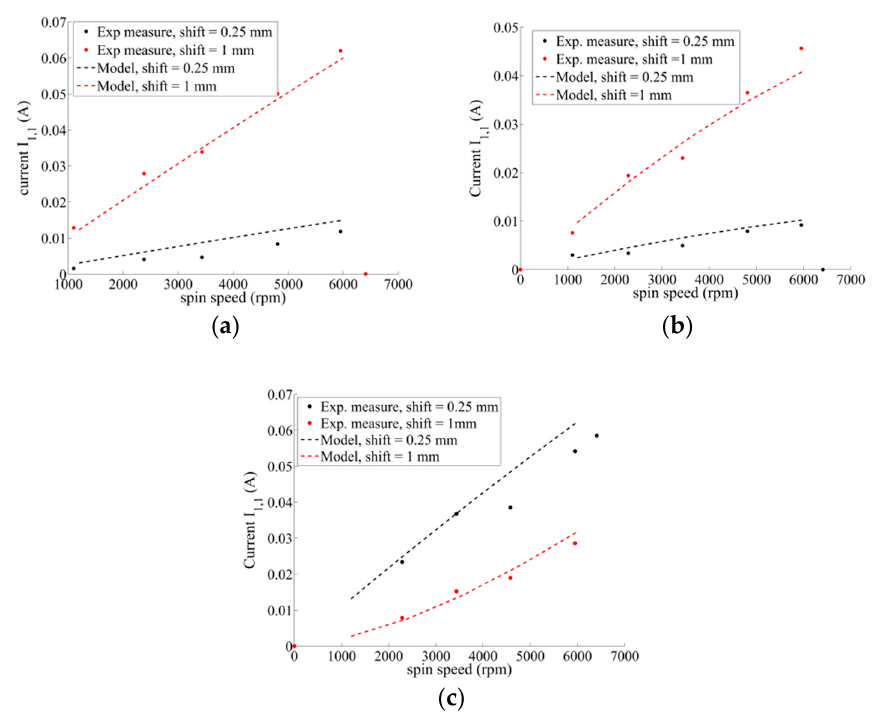
Figure 25. Measured and predicted current in first coil of first phase for center shifts of 0.25 and 1 mm in the case of the electrodynamic bearing prototype with ( a ) motor terminals in open circuit, ( b ) motor terminals in open circuit with one additional inductor on each coil, and ( c ) motor terminals with resistive load of 200 Ω and one additional inductor on each coil.